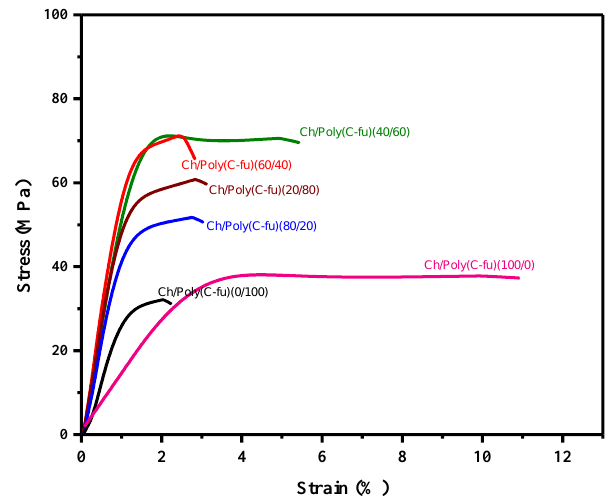
Figure 4. Stress – strain curves of poly (Ch/C-fu) films. Figure 4. Stress–strain curves of poly (Ch/C-fu)